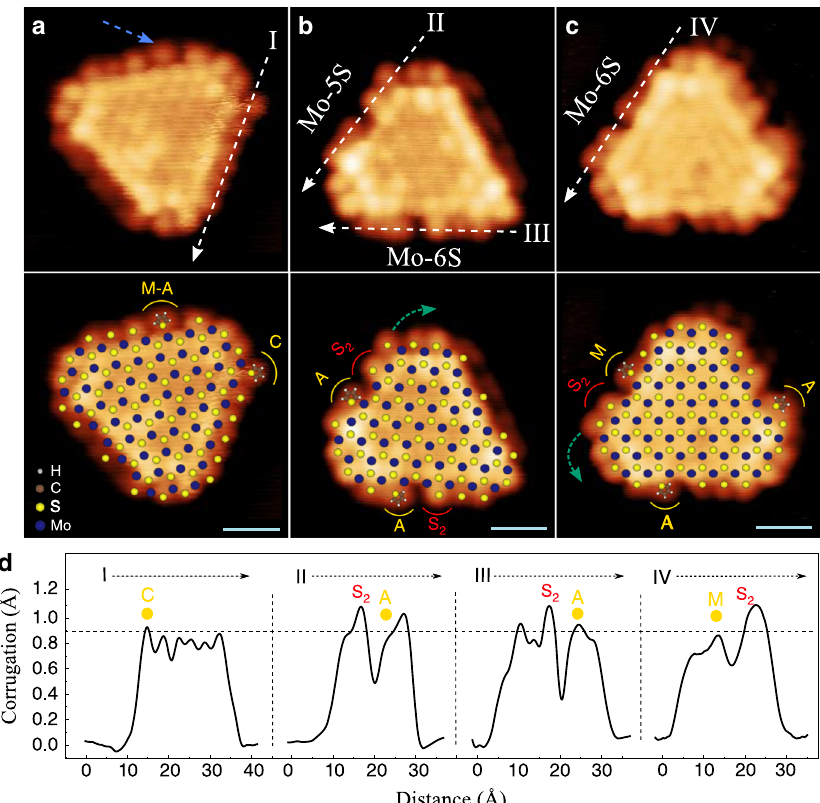
Fig. 5 Thiophene adsorption modes in STM. a – c Three cases of STM images of r -MoS 2 nanoparticles after exposure to thiophene at 300 K shown with a superimposed model shown below each image. The white dashed lines correspond to the direction of the edge pro fi le shown below. The blue dashed arrow indicates thiophene adsorption on M and A locations. The STM images with the superimposed nanoparticle lattice show the location of the thiophene molecules (yellow marks) and sulfur dimer formation (red marks), and atomic displacement direction indicated with green dashed arrows. STM parameters for a V t = − 0.22 V, I t = − 0.40 nA; b V t = − 0.25 V, I t = − 0.33 nA; and c V t = − 0.15 V, I t = − 0.28 nA. Scale bar is 1 nm in all images. d Linescans of the Mo-edge I, II, II, and IV represented in the STM